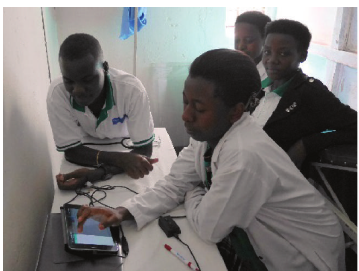
later generated from each data set which were evaluated as to whether or not they contained data of diagnostic